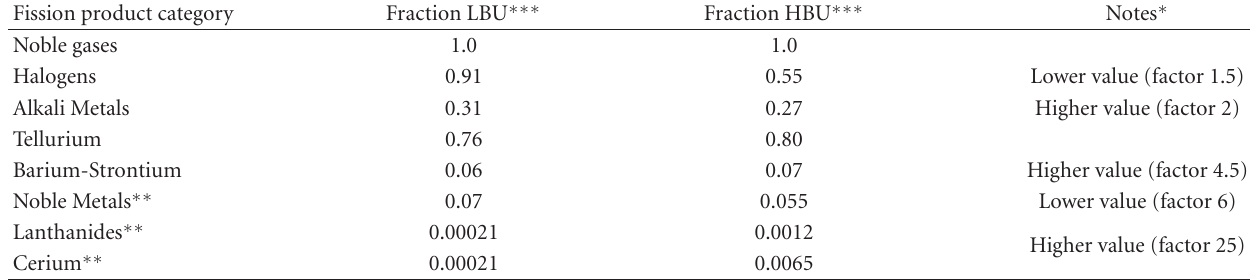
Figure 4: Sketch for radioactivity release (dotted lines are secondary flow paths for releases; ∗ applies after the end-of-the-accident, rows 15 and 6 in Tables 2(a) and 2(b)) . Table 4: Fraction of radioactivity release from core to containment in the case of LBU fuel (NUREG 1465, 1995 and SAND 7697, 2007, or [6, 16]).